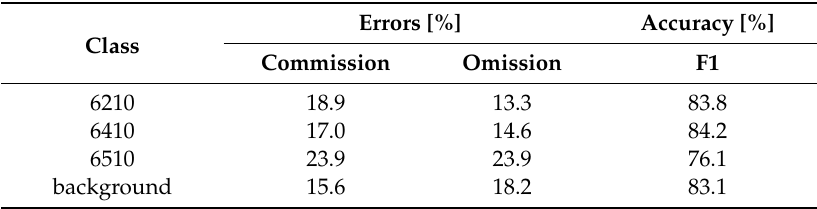
Table 6. Errors and accuracy of C1_C2_C3_MNF + TOPO class dataset (the highest mean of F1 values for all